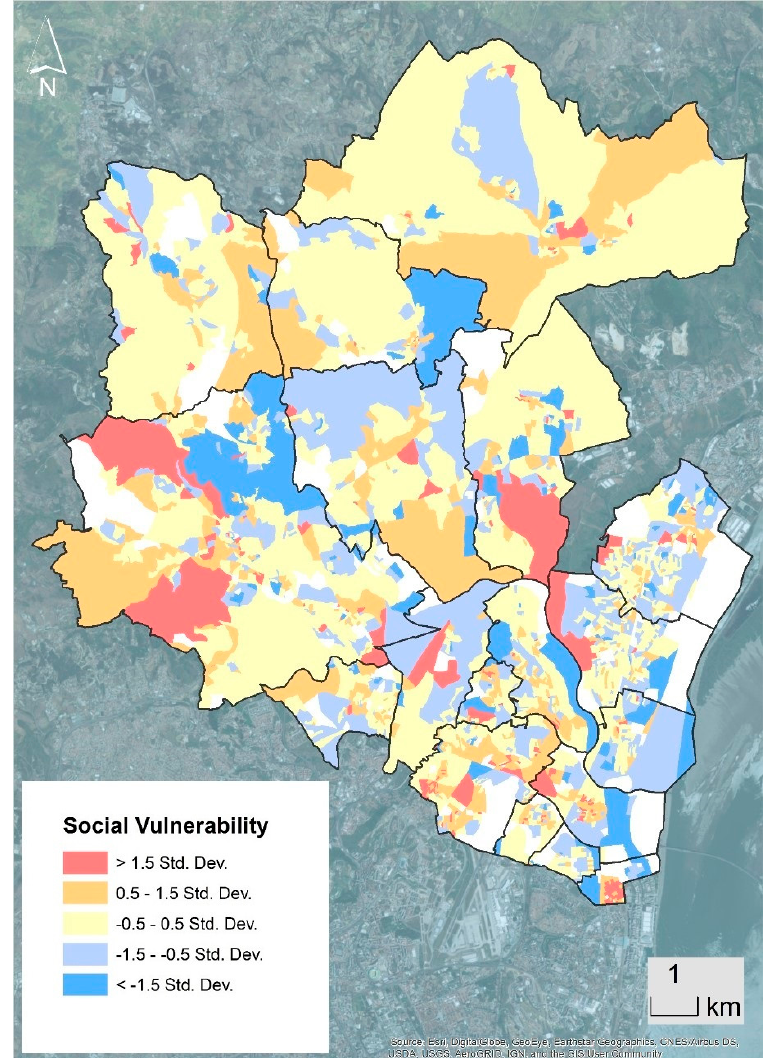
Figure 3. Social vulnerability of the Loures municipality. The civil parishes are delimitated (which names are indicated in Figure 1).